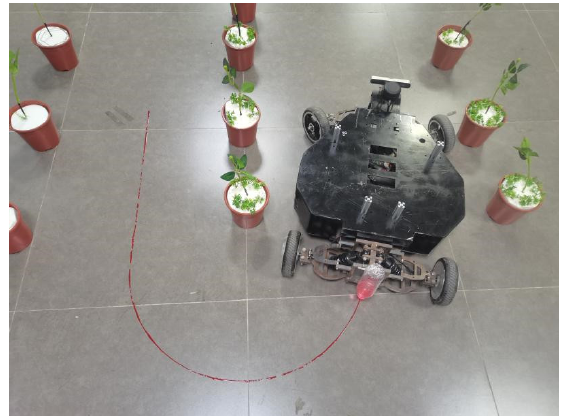
Figure 19. Experiment scene of steering in the laboratory. At the starting steering point of the robot chassis, the vertical projection point of the bottle on the ground is taken as the origin, the traveling direction of the robot chassis is taken as the Y -axis, and the direction perpendicular to the traveling direction is taken as the X -axis, to establish the plane cartesian coordinate system. A semicircle with a radius of 40 cm is chosen in the coordinate system, and the starting and ending point coordinates are (0, 0) and (80, 0). The semicircular arc is taken as the ideal turning trajectory for the robot chassis. The robot chassis is placed at the origin (0, 0), and the robot is controlled to turn along the semicircular arc. The red ink trace on the ground is taken as the actual track of the chassis during turning. The ideal trajectory is divided into 12 equal, ideal trajectory points. Then, the equally divided points are connected with the center of the circle, and the intersection point between the two lines and the actual trajectory is taken as the actual trajectory point. The coordinates of the ideal and actual trajectory points are both recorded, and the deviation in their distances is calculated according to Equation (9). The results are shown in Table 2. The data in Table 2 were imported into MATLAB for curve fitting, and the ideal, and the actual trajectories of the chassis during turning are presented on two-dimensional planes, as shown in Figure 20.